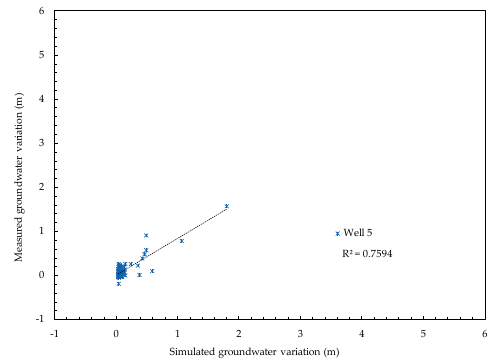
Figure 10. The model testing correlation relationship of Well 5.